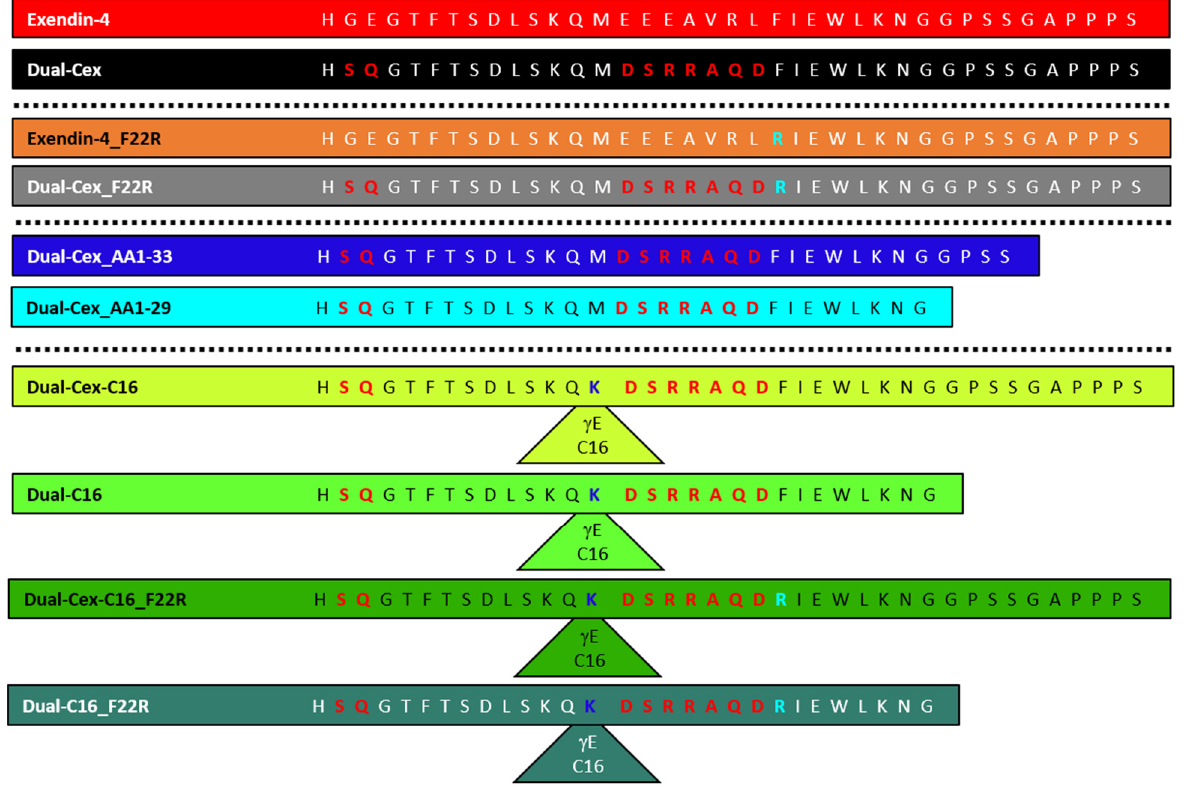
Figure 1. Amino acid sequences of all peptides. Sequence stretches of the dual agonist peptides derived from Glucagon are marked in bold red letters. Substitution of a Phe residue at position 22 by Arg is indicated in bold cyan letters. In the fatty acid-conjugated peptides, Ser in position 2 was replaced by D -Ser and Met at position 14 was replaced by Lys (blue), which was conjugated to γ -glutamic acid followed by a fully saturated palmitic acid chain indicated by triangles.